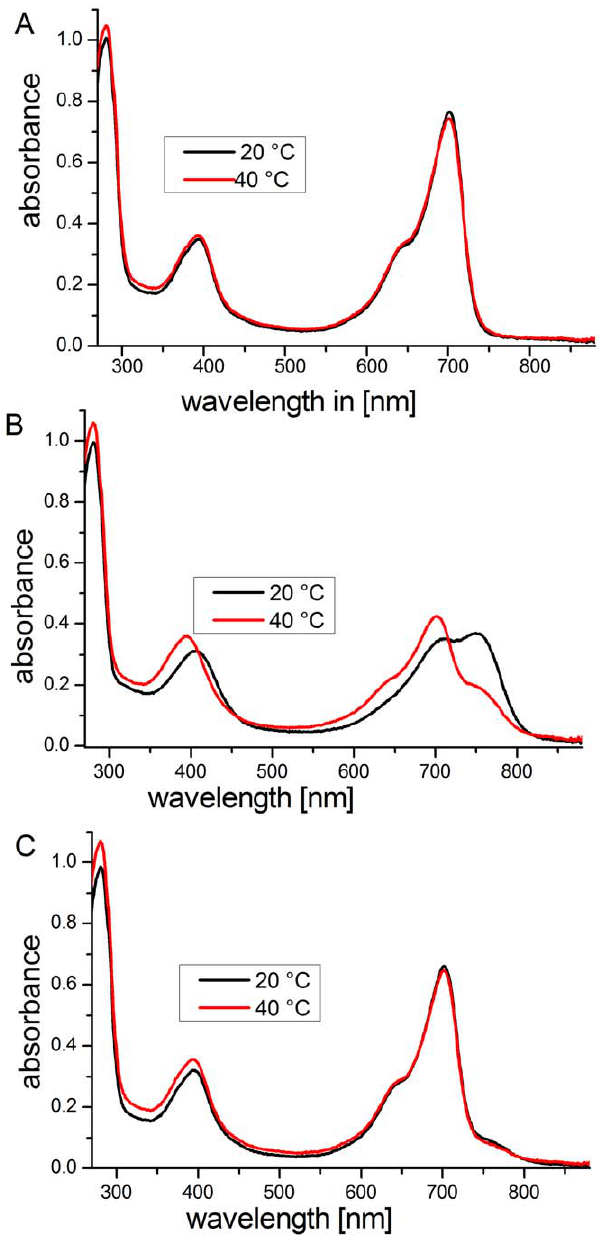
Figure 7. Absorption spectra of Agp1 during and after incubation at 20 6 C (black) or 40 6 C (red). (A) Non-irradiated Agp1 at 20 u C and 40 u C. (B) After red irradiation (20 min; 655 nm; 20 m mol m 2 2 s 2 1 ). (C) Both measurements are performed at 20 u C after saturating far-red irradiation.